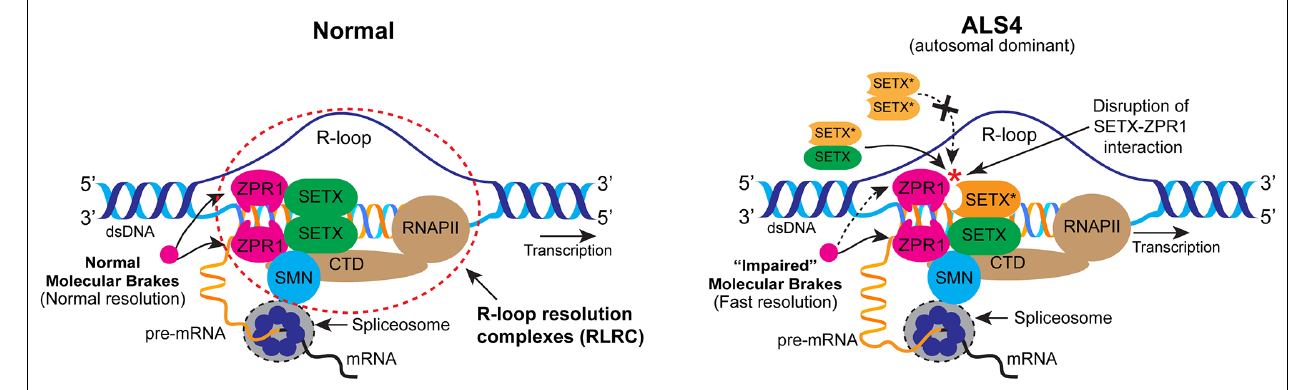
FIGURE 5 | Mechanism of R-loop resolution under the normal and ALS4 disease conditions. In normal cells, ZPR1 binds RNA Pol II (RNAPII) COOH-terminal (CTD) domain. ZPR1 binds to SETX and recruits SETX onto R-loops. ZPR1 tethers to RNA:DNA hybrids and may function as a “molecular brake” to regulate the speed of SETX-dependent R-loop resolution. Nascent RNA hybridized to DNA is separated by the activity of R-loop-resolution complexes (RLRC; dotted ellipse) to make pre-mRNA available for processing and splicing. In ALS4, mutation in SETX (L389S) disrupts its interaction with ZPR1. However, mutation does not affect SETX dimerization. ZPR1 fails to recruit mutant SETX* (orange) homodimer but recruits SETX-SETX* (green - orange) heterodimer onto R-loops. Recruitment of heterodimer results in the partial impairment of the molecular brake and increase in the speed of SETX-dependent R-loop resolution leading to gain-of-function and fewer R-loops in patient